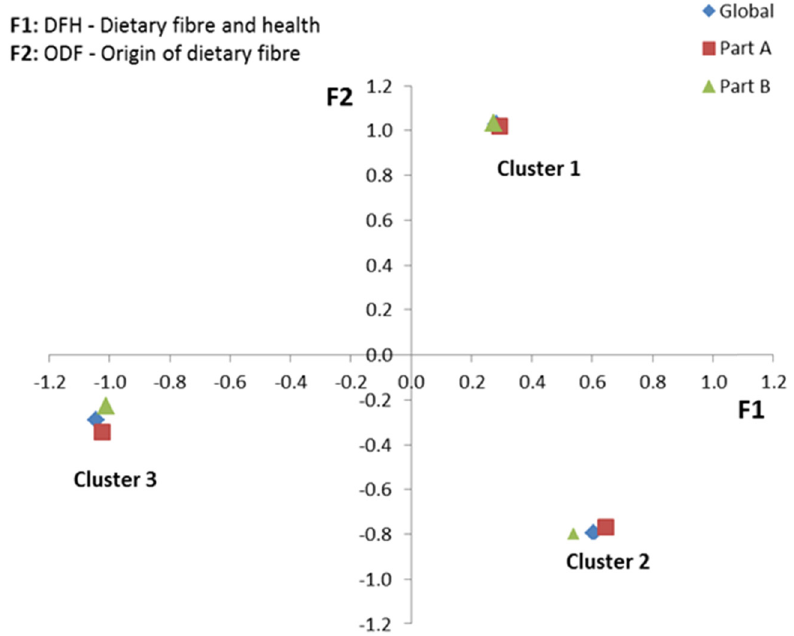
Figure 3: Location of cluster centers in the global and partial solutions.